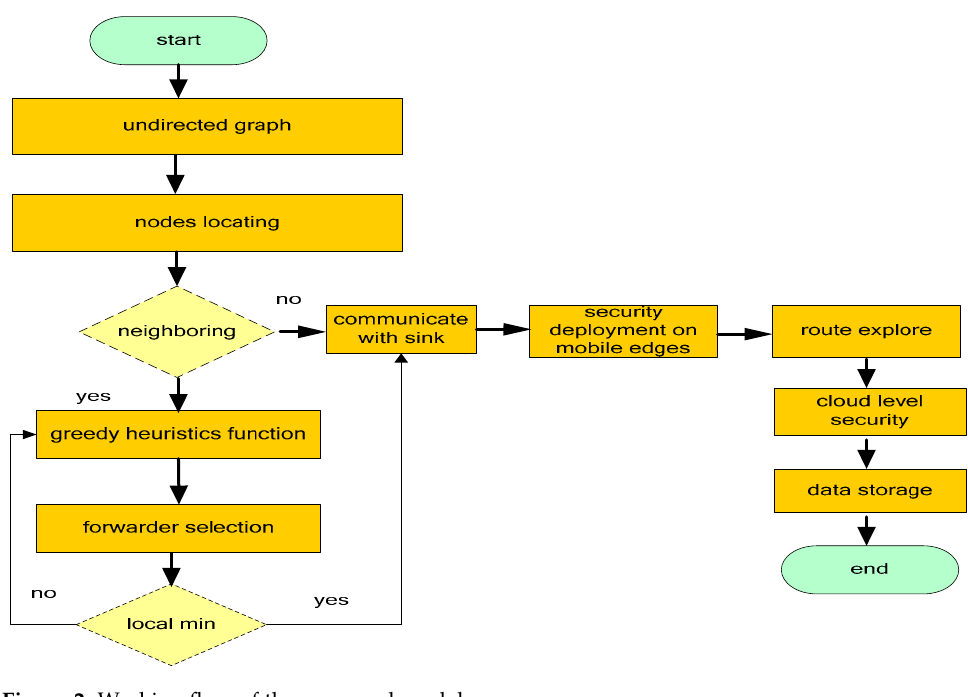
Figure 2. Working flow of the proposed model.